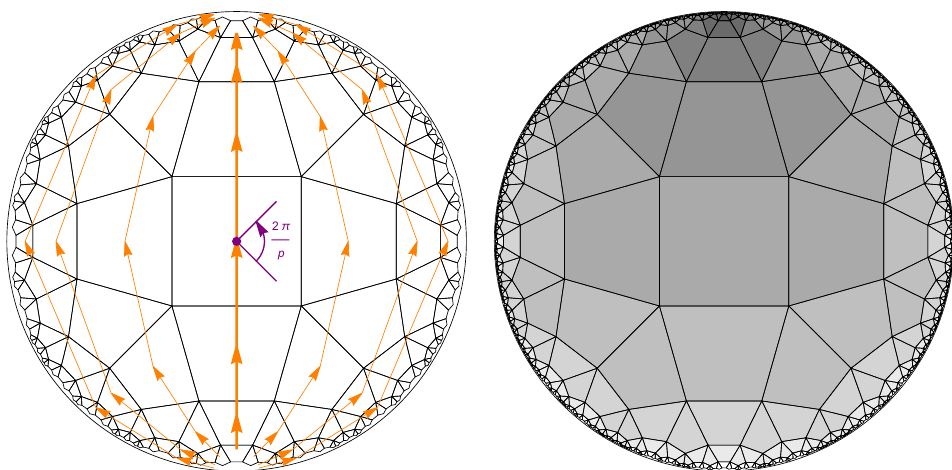
Figure 13: Left: Visualization of the action of two elements of the Fuchsian group describing the isometries of a { p , q } tiling. The rotation by an angle 2 π/ p around the center of the Poincaré disk is denoted in purple. The effect of a boost of the central tile and how the rest of the tiles are transformed by this isometry is shown by the orange arrows. Right: The Poincaré foliation. The different leafs are represented by different shades of gray. This indicates an inflation direction different from the radial foliation shown in Fig.